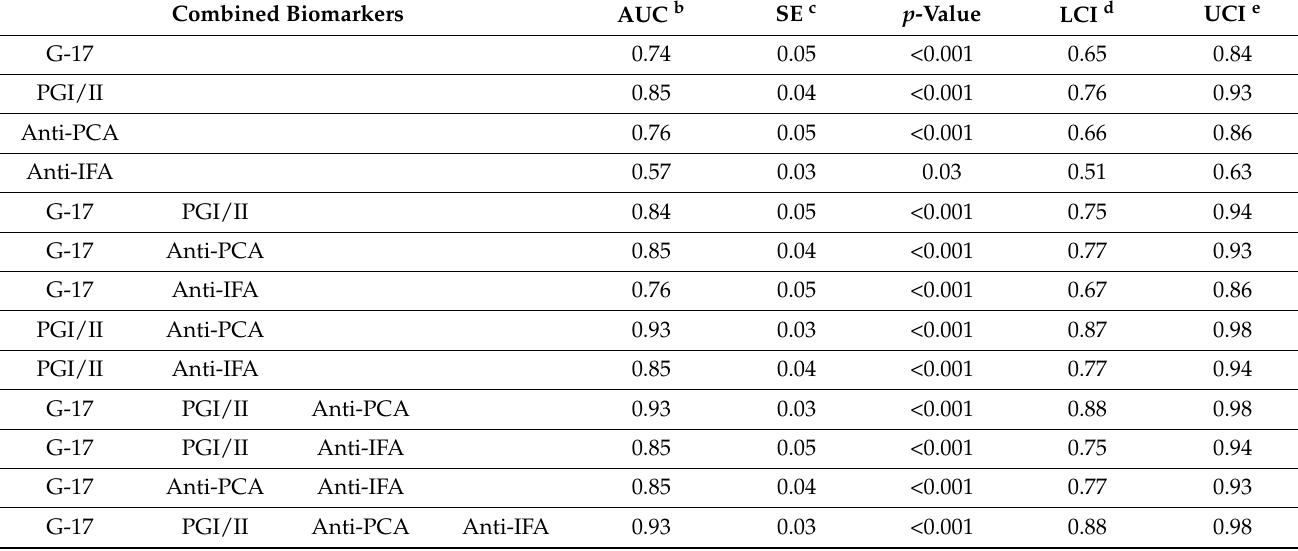
Table 5. Combined biomarker G-17, PGI/II ratio, anti-PCA and anti-IFA area under the ROC a curve